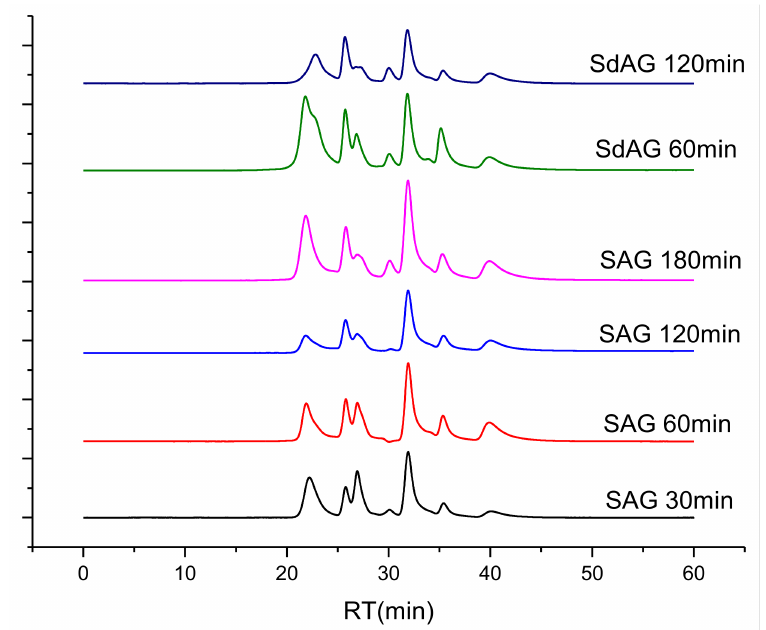
Figure 5. Gel permeation chromatograms of the solutions of sulfated arabinogalactan samples at a temperature of 85 ◦ C, the ratio of the amount of the complex to the amount of the polysaccharide corresponds to 1:15